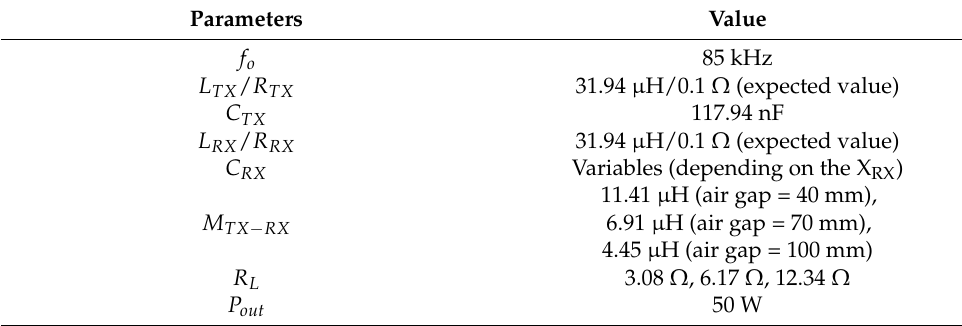
Table 4. Electrical parameters of the circuit